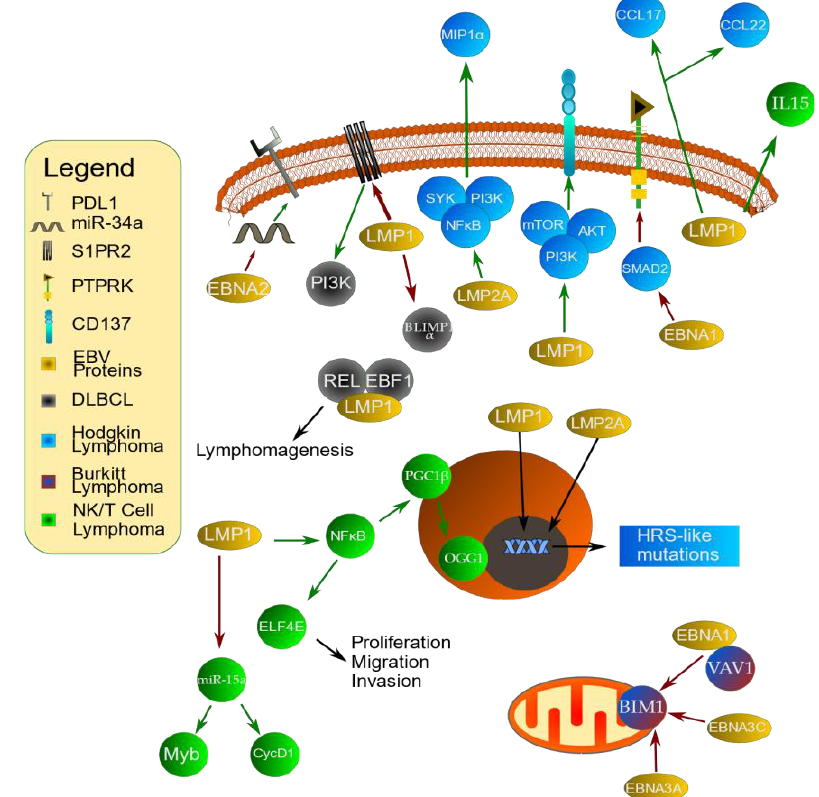
Figure 2. EBV-associated latent proteins and tumorigenesis. EBV latent proteins are strongly associated with tumorigenesis. For example, in diffuse large B-cell lymphoma (DLBCL), represented by dark gray in the figure, LMP1 inhibits BLIMP1 α and S1PR2. S1PR2 inhibition allows for increased PI3K signaling. It also cooperates with REL and EBLF1 to promote lymphomagenesis. EBNA2 inhibits miR-34a, which allows for increased expression of PDL1. In Hodgkin lymphoma, represented by blue in the figure, LMP1 stimulates CD137 activity through the PI3K/AKT/mTOR pathway. It also promotes expression of the chemokines CCL17 and CCL22. Furthermore, it promotes